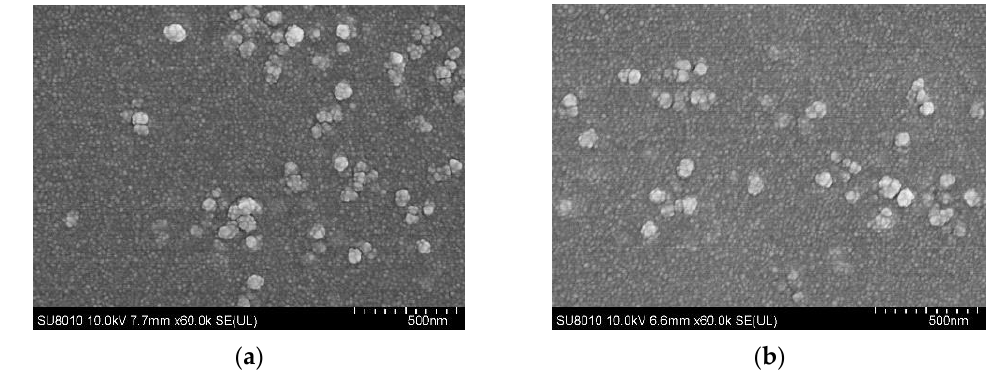
Figure 2. SEM images of PLGA ( a ) and chitosan nanospheres ( b ) loaded with pVAX1-SIR2 plasmids. PLGA and chitosan nanospheres were synthesized by double emulsion evaporation technique ( w/o/w ) and ionic gelation technique. After being totally freeze-dried, nanospheres were imagined at magnification of ×30,000 (bar represented 500 nm).